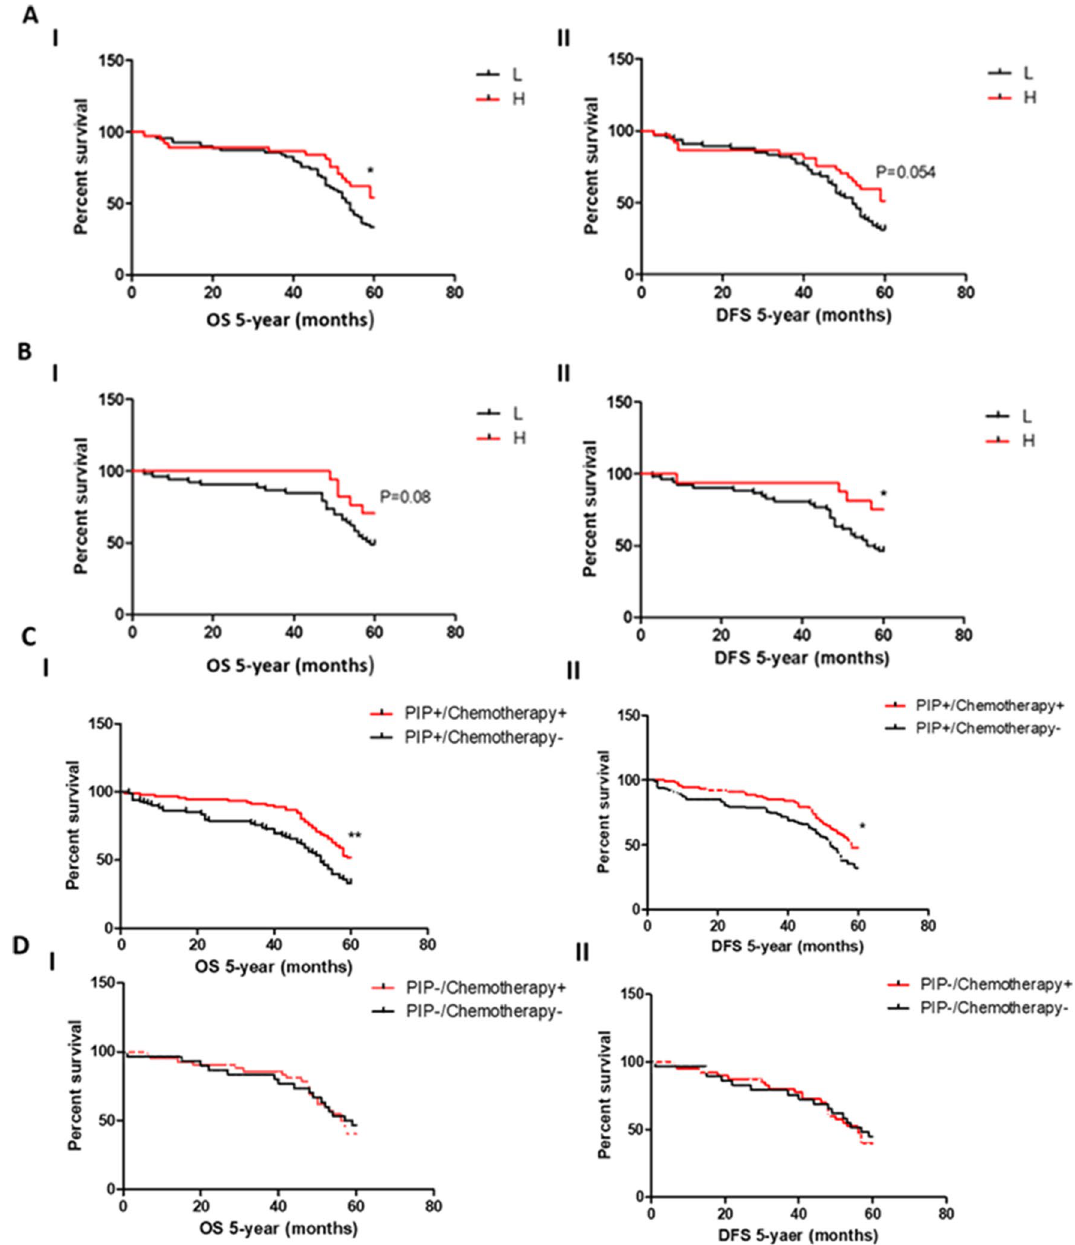
Figure 5. Survival analysis of IDC patients receiving adjuvant chemotherapy during the 5-year follow up. Patients with higher PIP expression ( A ) at protein (IHC) and ( B ) mRNA (RT-PCR) levels were characterized by longer ( I ) 5-year overall survival and ( II ) 5-year disease-free survival (* p < 0.05). ( C ) PIP (IHC)-positive patients (PIP+) receiving adjuvant chemotherapy were characterized by longer ( I ) 5-year overall survival and ( II ) 5-year disease-free survival (*p = 0.017, **p = 0.0018) in contrast to group of ( D ) PIP-negative